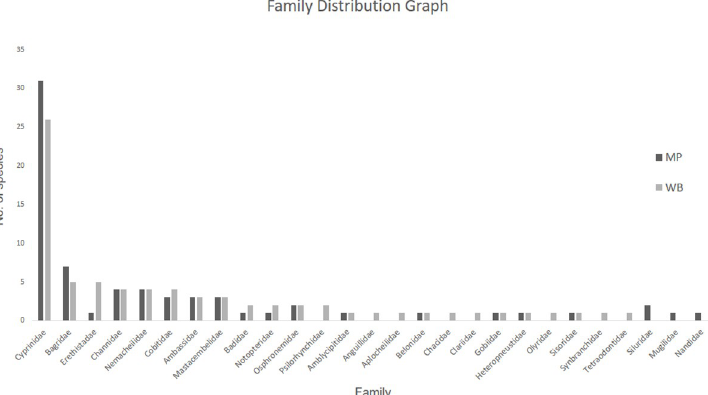
Fig 4. Comparison of fish family distribution across Madhya Pradesh and West Bengal. Among the 24 fish families in WB and 19 families in MP, Cyprinidae was the most dominant family (MP = 45%, WB = 34.25%) followed by Bagridae (MP = 10.14%, WB = 6.85%) and Channidae and Nemacheilidae (MP = 5.79%, WB = 5.48%) in both regions.